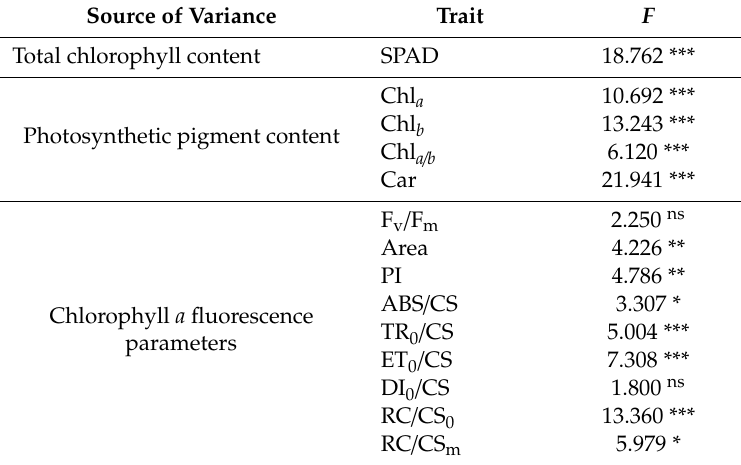
Table 2. F -statistic from one-way analysis of variance of the traits measured in control oat